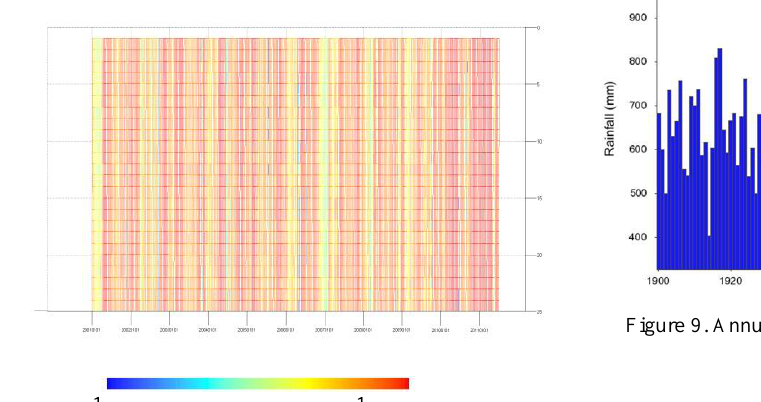
-1 1 Figure 8. Seasonal variation removed NDVI time series in 3D. Close attention should be paid to these unusually low NDVI peaks with values below -0.6 in blue colour, circulated as A, B, and C in the figure 7-A and 7-B. Peak A is in later 2002, B mid 2006, and C around mid 2010. The mid 2005 also shows low value. A, B, and C are corresponding to blue colour lines in figure 8 located in cell order and imaging time. In addition, the causes behind the NDVI spikes of unusually low value in Figure 7-A and 7-B could be analysis from the history of well drilling and pipeline construction activities in the Otway CCS site: